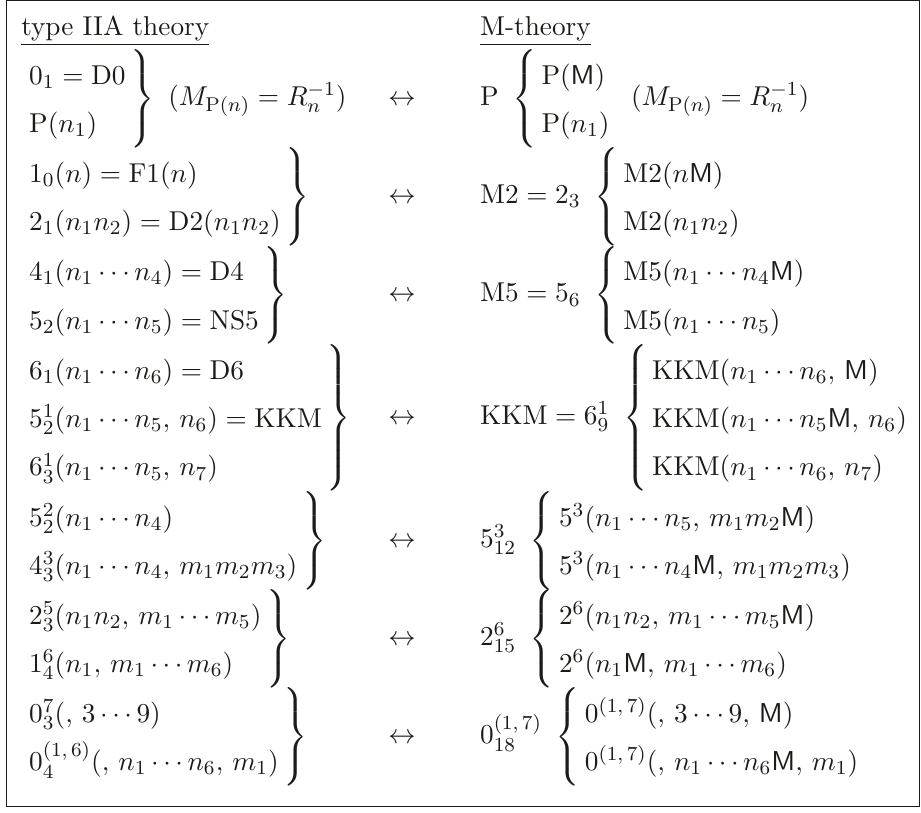
Table 3 . Defect branes in the type IIA theory/ T 7 and the M-theory/ T 8